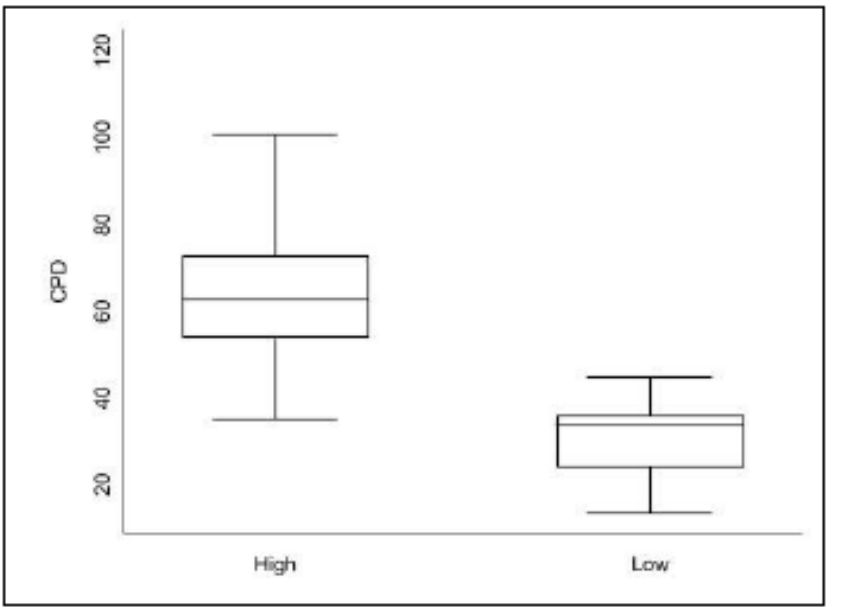
Figure 3. Whisker plot of CPD values of high (n = 25) vs. low (n = 9) VIS. High VIS CPD value (65.68) was significantly higher compared to low VIS CPD value (29.79) ( p =